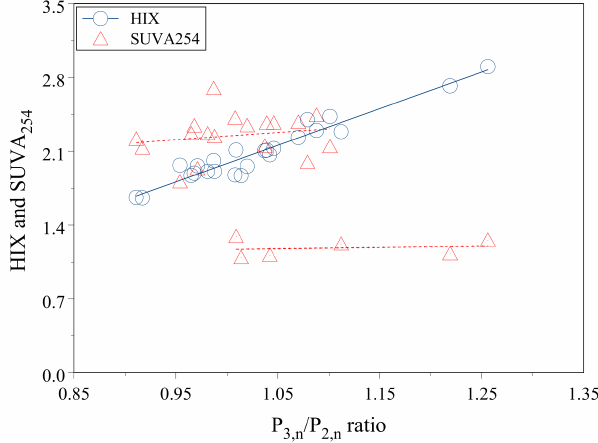
Figure 4. The linear correlation of optical indicators HIX and SUVA 254 with P III,n /P II,n